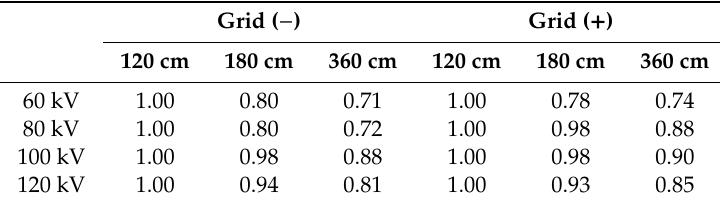
Table 4. The relative values of breast surface doses (BSDs) in the anteroposterior view (normalized at 120 cm).